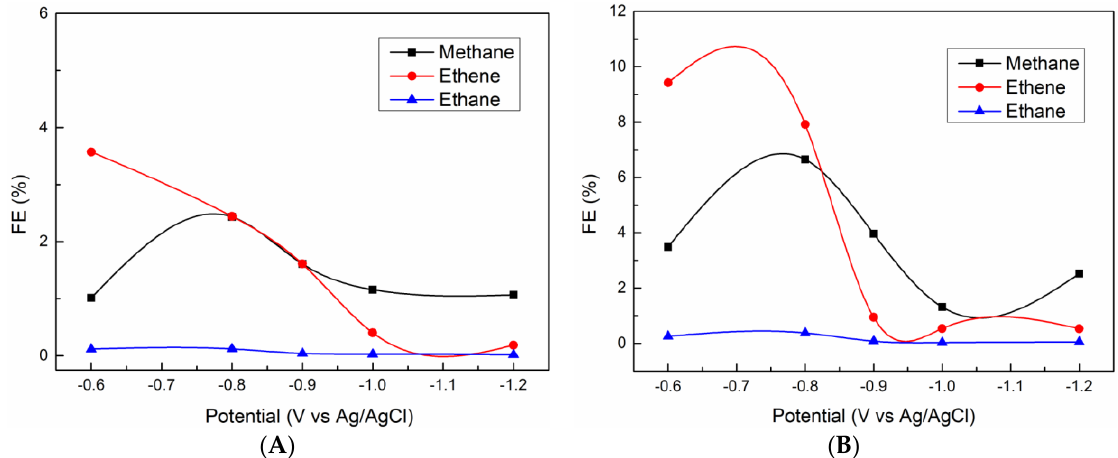
Figure 9. FE values for the ( A ) PL-12h and ( B ) HL-12h as a function of the potential.